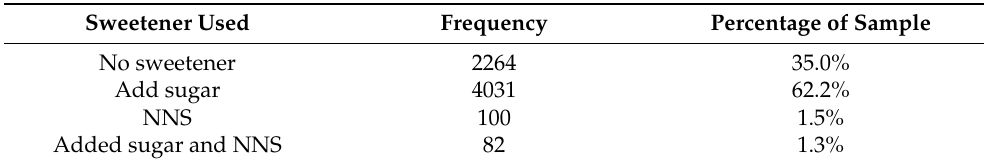
Table 2. Frequency and proportion of sweeteners used in new products that displayed a HSR between